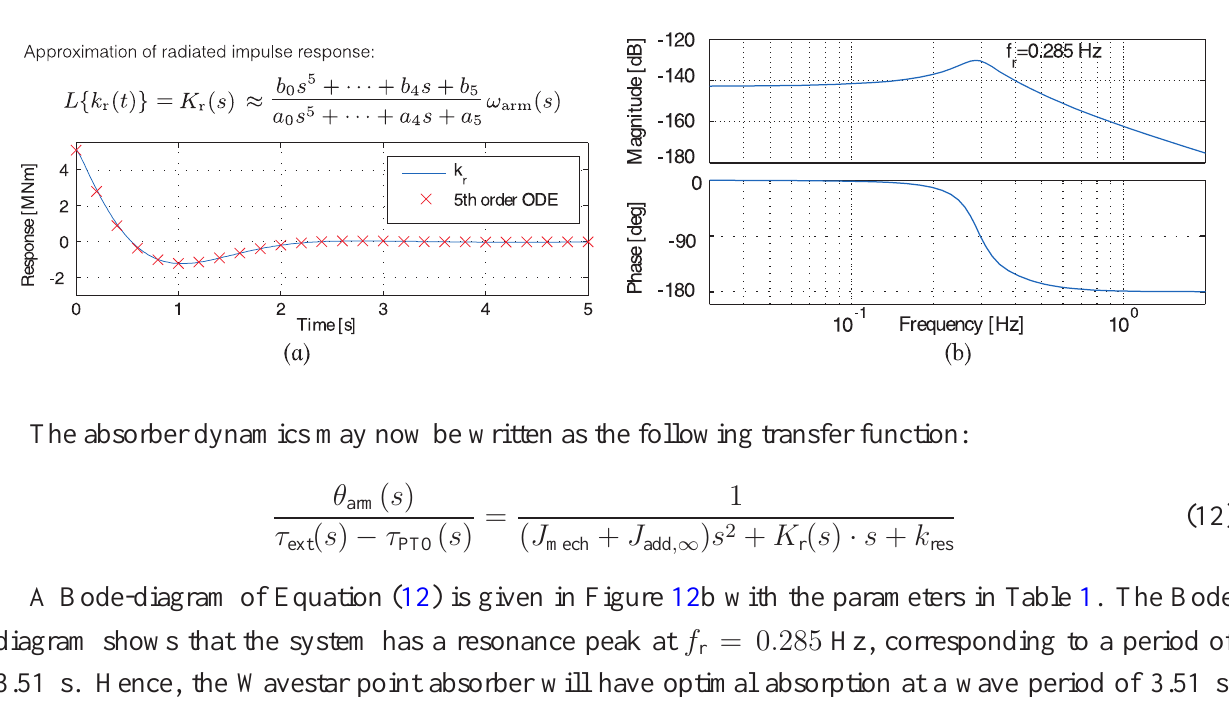
( t ) , being approximated; and ( b ) Bode r ( s ) /τ ( s ) arm ext